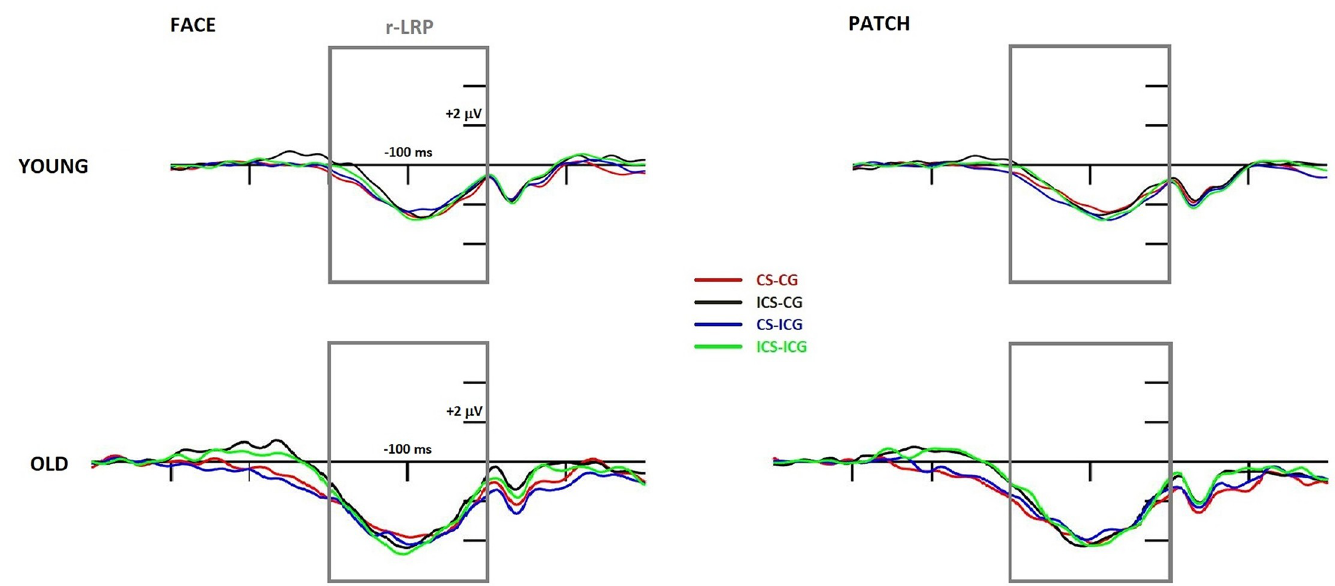
Fig 8. Response-locked LRP component at the C3-C4 electrode difference (contra-minus-ipsilateral to the responding hand) in young (top panel) and older (bottom panel) adults and in face (left side) and patch (right side) trials. The x-axis represents the epoch from -400 ms to 200 ms around the time-point of the response. CS-CG (congruent Simon, congruent gaze) waveforms are displayed in red, ICS (incongruent Simon)-CG waveforms in black, CS-ICG (incongruent gaze) waveforms in blue, and ICS-ICG waveforms in green. Grey rectangles represent the search window for maximal r-LRP amplitude in every subject.